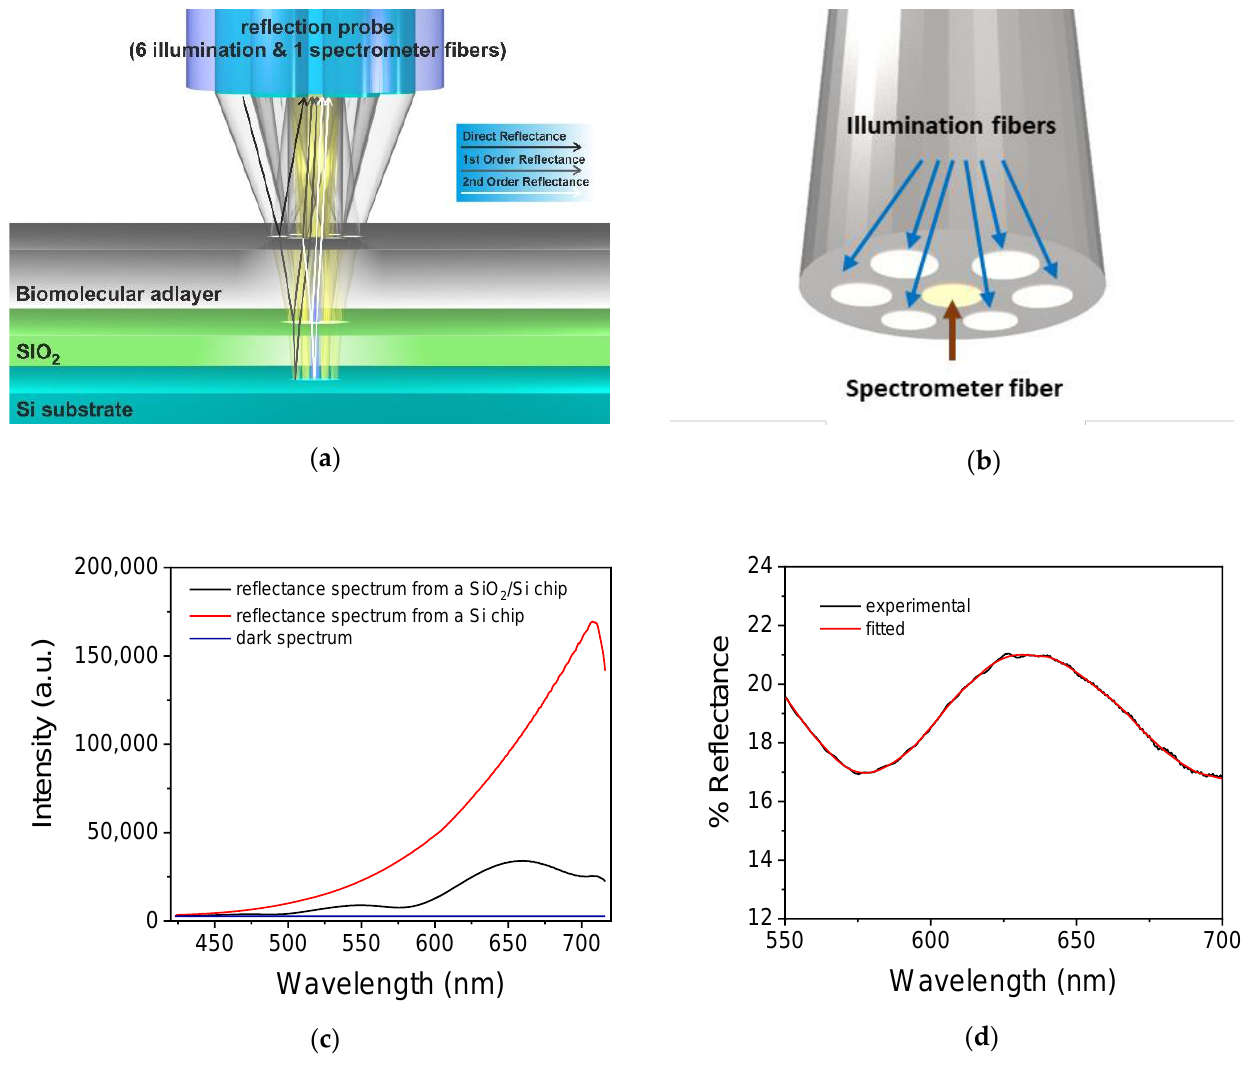
Figure 1. ( a ) Schematic of WLRS detection principle showing the paths of the light from the six illumination fibers of the reflection probe and the collection of the reflected light by the central spectrometer fiber. The light is reflected by the Si substrate (2nd order reflectance), then at the Si/SiO 2 and SiO 2 /biomolecular adlayer interface (1st order reflectance), and finally by the biomolecular adlayer/solvent interface (direct reflectance), creating an interference spectrum. Reprinted with permission from [94] copyright (2017) Elsevier Ltd. ( b ) Schematic of the reflection probe showing the positioning of the six illumination fibers at its periphery and of the seventh central fiber that collects the reflected light and guides it to the spectrometer. ( c ) Graph showing the reference reflectance spectrum acquired from a Si chip (red line), the dark spectrum acquired with the light source turned off (blue line), and the reflectance spectrum SiO 2 /Si chip (black line). ( d ) Graph presenting a typical normalized experimental reflectance spectrum (black line) and the respective fitted spectrum (red line).